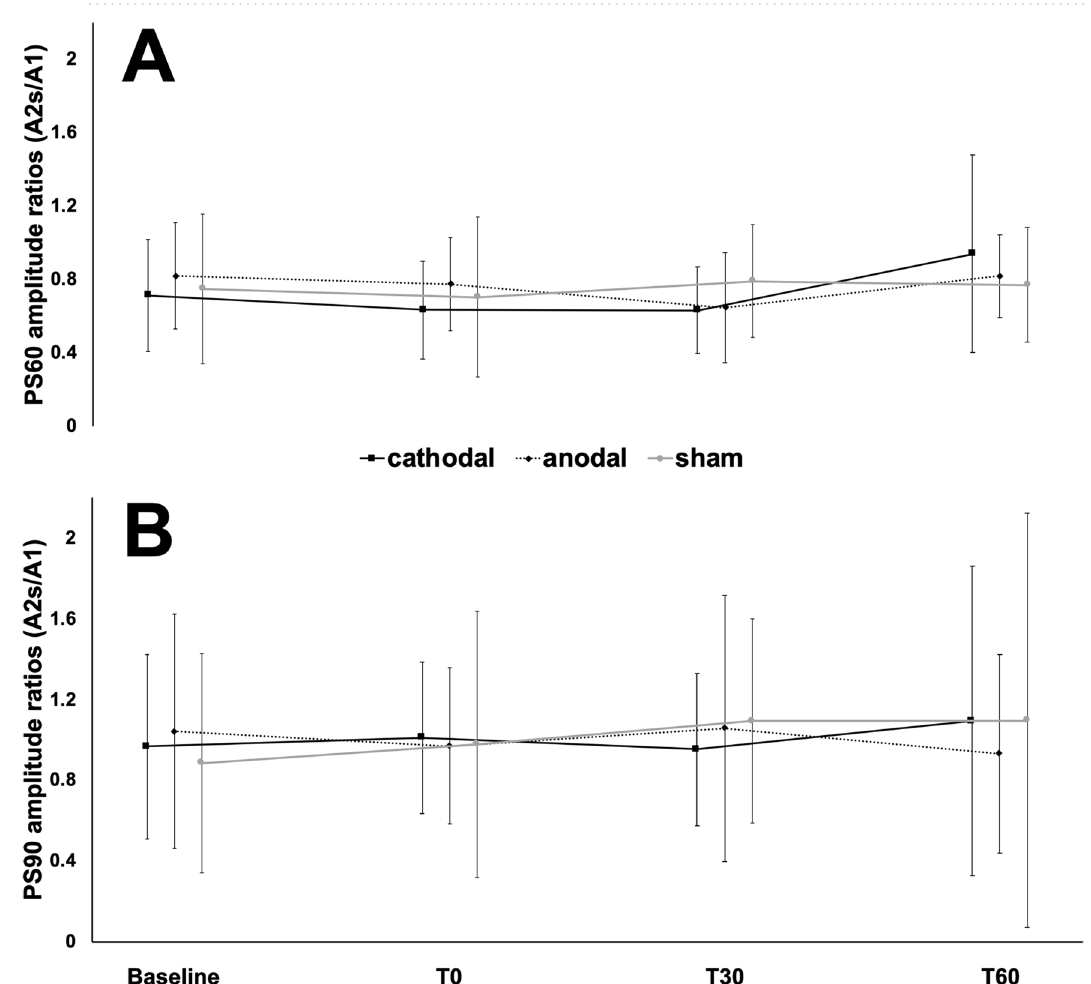
Figure 3. ( A / B ) The plots show the progress of paired stimulation suppression ratios (A2s/A1) recorded over Cz’ following stimulation of the tibial nerve with an interstimulus interval of 60 (PS60; A ) and 90 (PS90; B ) ms. The black line shows progress after cathodal, the dotted line after anodal and the grey line after sham transcutaneous spinal direct current stimulation. Recordings took place before (baseline), immediately (T0) as well as 30 (T30) and 60 (T60) min after stimulation. y-axis: amplitude ratios (A2s/A1). x-axis: points of